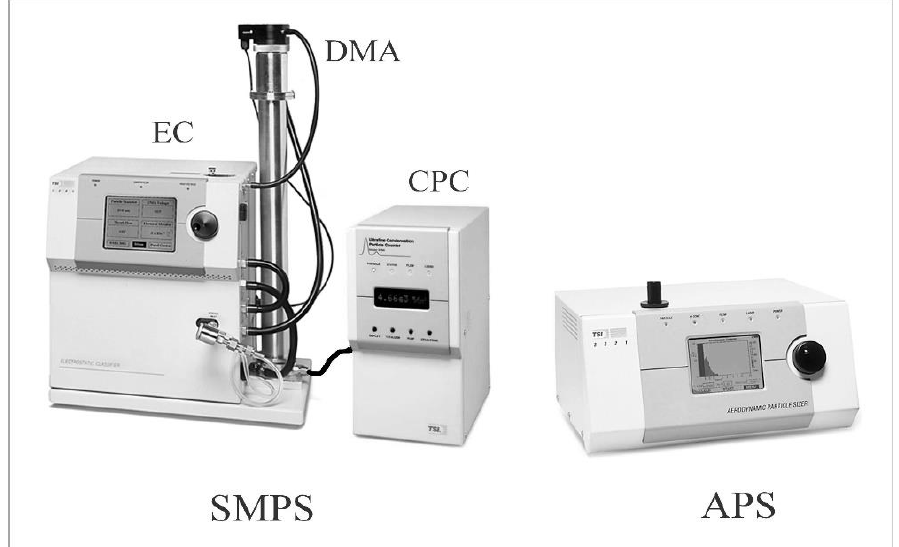
Figure 4. SMPS and APS particle spectrometers used in measurements. The relative humidity in the chamber was changed in the range of 20–90%. During the tests, the aerosol flow rate was 0.3 dm 3 /min, which allowed recording particles in the range of 10–700 nm divided into 107 measurement channels. The SMPS spectrometer consists of three main units: an electrostatic classifier (EC), a differential mobility analyzer (DMA), and a condensation particle counter (CPC). At the aerosol inlet of the first unit there is a single-stage impactor (filter) which removes particles outside the measurement range. Inside the EC panel there is a column with a beta radiation source (Kr-85: β + ), which ionizes the flowing aerosol and the particles to quickly reach a state of charge equilibrium. Inside the DMA column, aerosol-containing air combines with a ten times stronger stream of aerosol-cleaned air to maintain laminar flow along the column